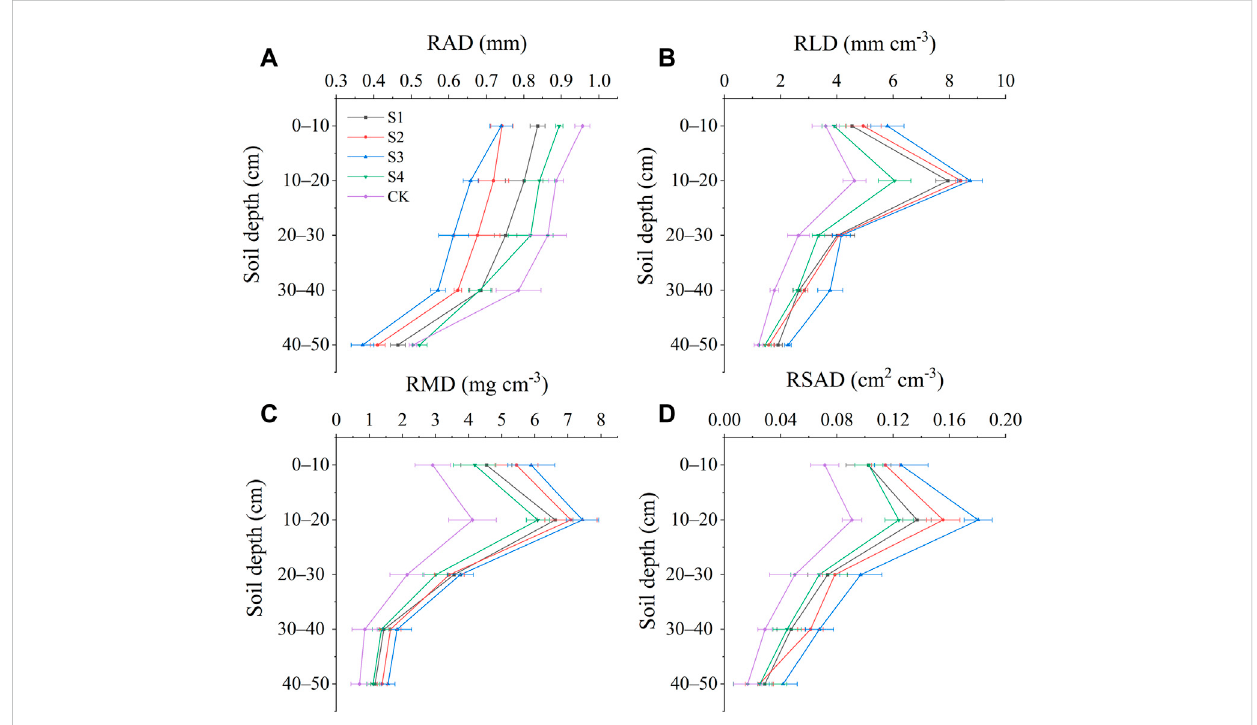
FIGURE 3 Changes in root traits with soil depth for different stump heights. (A) Average root diameter, (B) root length density, (C) root mass density, and (D) root surface area